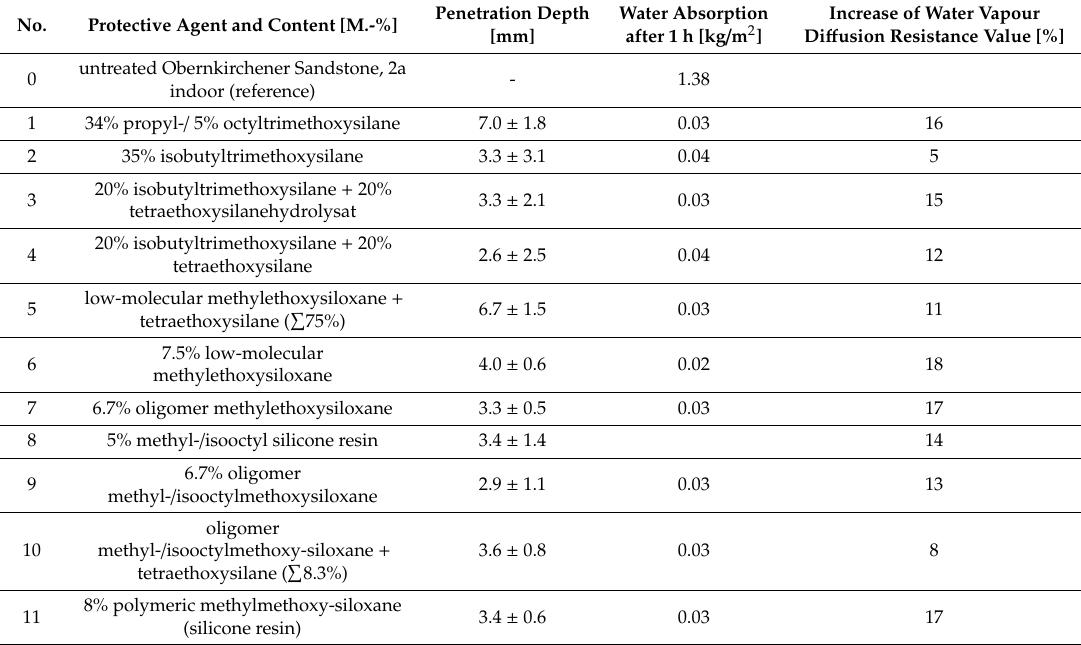
Figure 1. Left: The geometry of the samples and the sampling of the sample slices after 2 and 30 years, here marked green (years = a). Right: Outdoor weathering of the samples in Nuremberg after an exposure time of 30 years. Table 2. Overview of the applied protective agents and characteristic values of Obernkirchener Sandstone treated with these agents (±standard deviation).